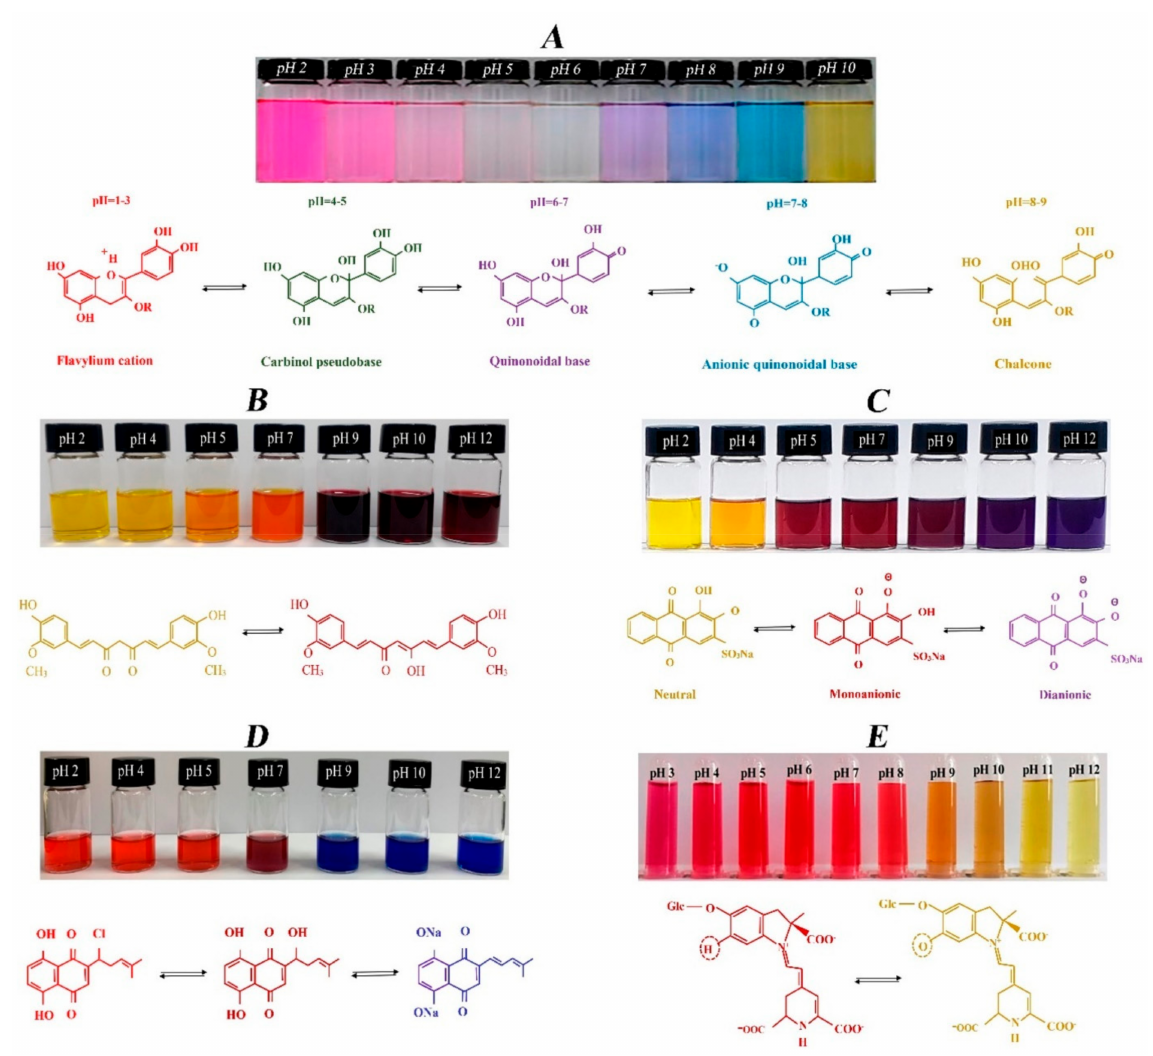
Figure 5. The color changes of ( A ) anthocyanin, ( B ) curcumin, ( C ) alizarin, ( D ) shikonin, and ( E ) betalains at different pH levels